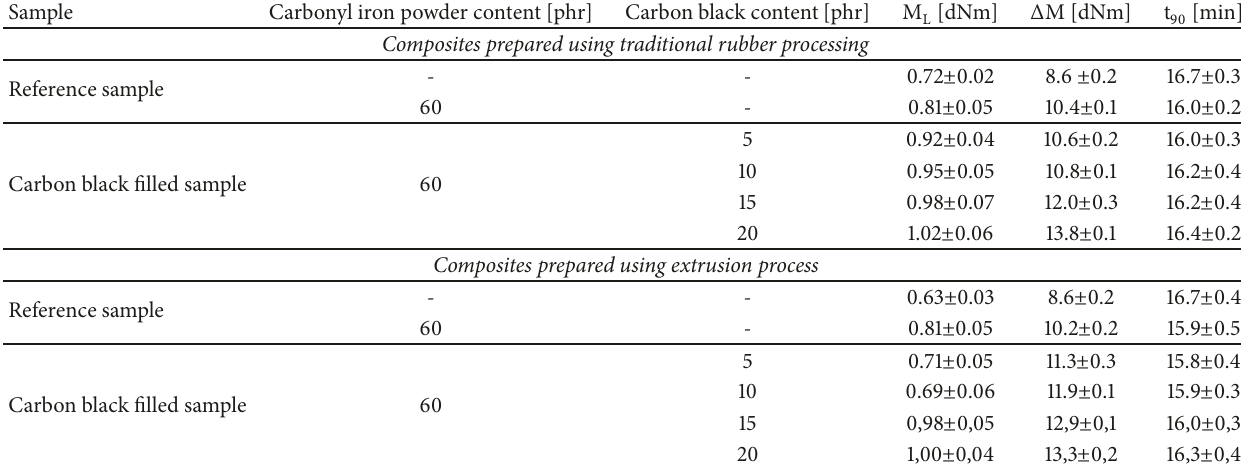
Table 2: Rheological properties of magnetorheological rubber mixtures filled with carbon black in different contents (0-20 phr) prepared by traditional rubber processing and extrusion